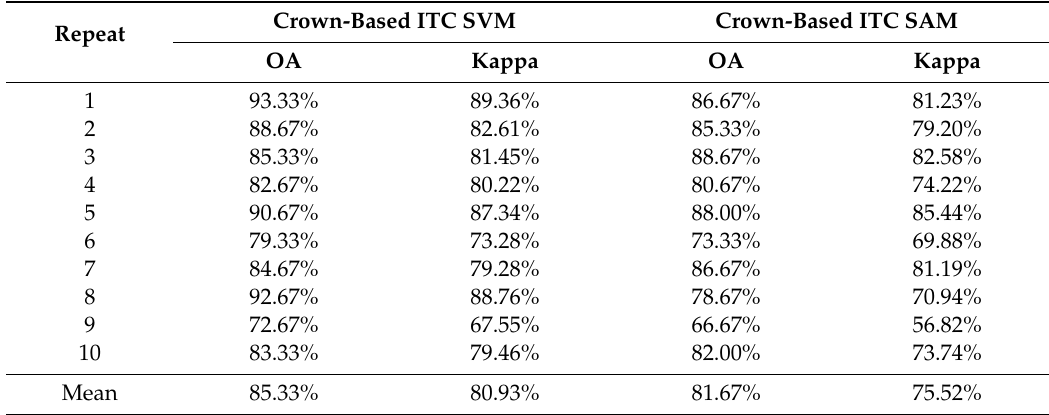
Table 4. Validation result statistics for crown-based